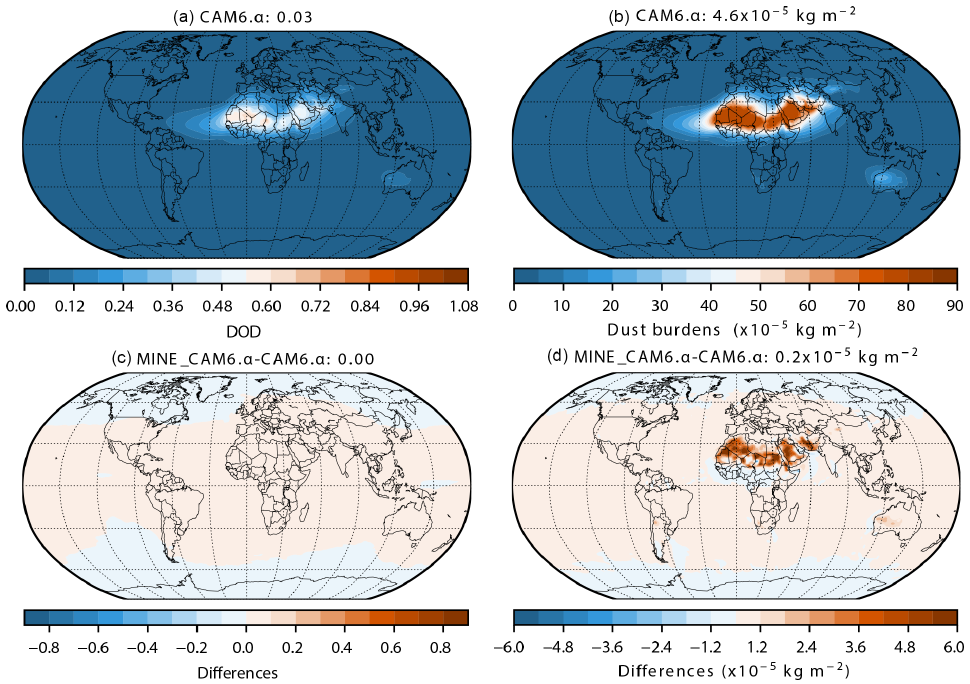
Figure 13. The same as Fig. 12 but for DOD ( a : global annual mean = 0.030 and (c) global mean difference = 0.001) and dust burdens ( b : global annual mean of dust mass = 24Tg and (d) global mean difference ≈ 0Tg), respectively.